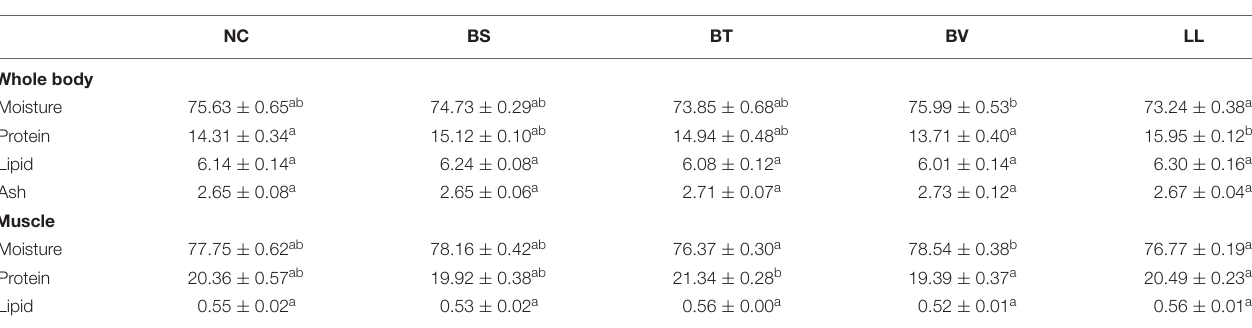
TABLE 3 | Body composition analysis (%, wet weight) of